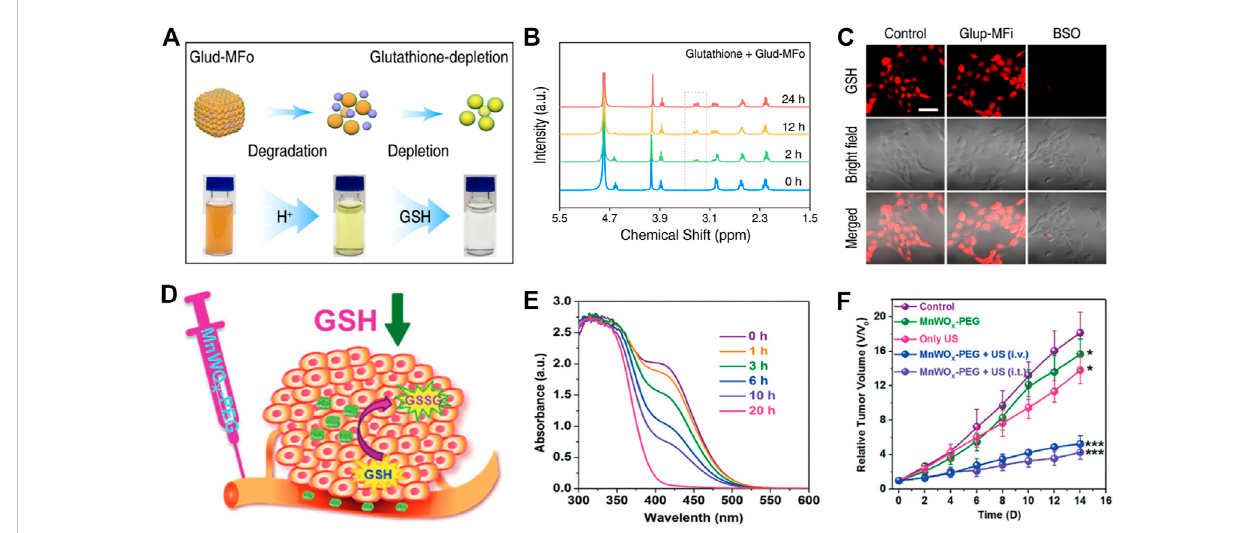
FIGURE 6 (A) Schematic diagram of Glud-MFo-c degradation in an acidic environment. (B) Hydrogen-nuclear magnetic resonance spectra ( 1 H NMR) of GSH after incubation with Glud-MFo-c at different time points. (C) Comparison of GSH content in confocal images after different treatment of 4T1 cells. Reproduced with permission. Copyright 2020 American Chemical Society. (D) A diagram of GSH depletion mechanism in tumor tissue. (E) The GSH consumption performance of MnWO X -PEG at different time points. (F) Tumor growth of mice after different treatments. Reproduced with permission. Copyright 2019 John Wiley &